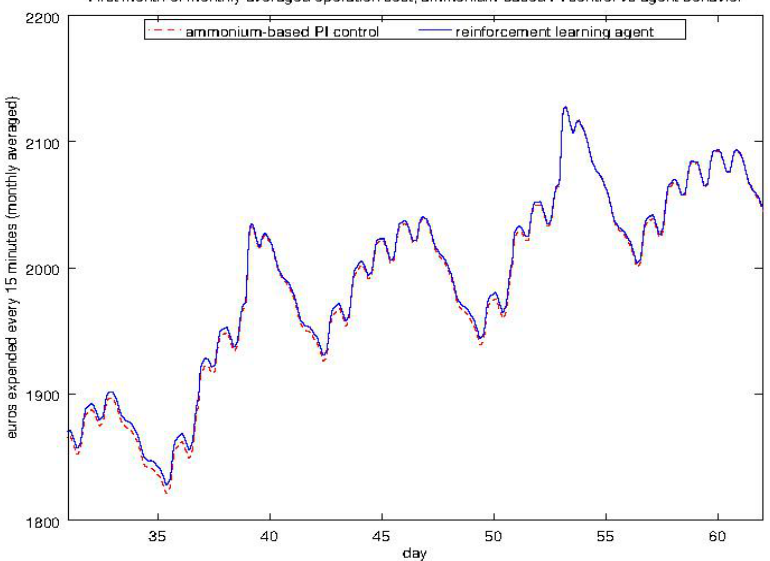
Figure 14. Ammonia-based PI control vs. the RL agent’s behavior: first month of monthly averaged operation cost.